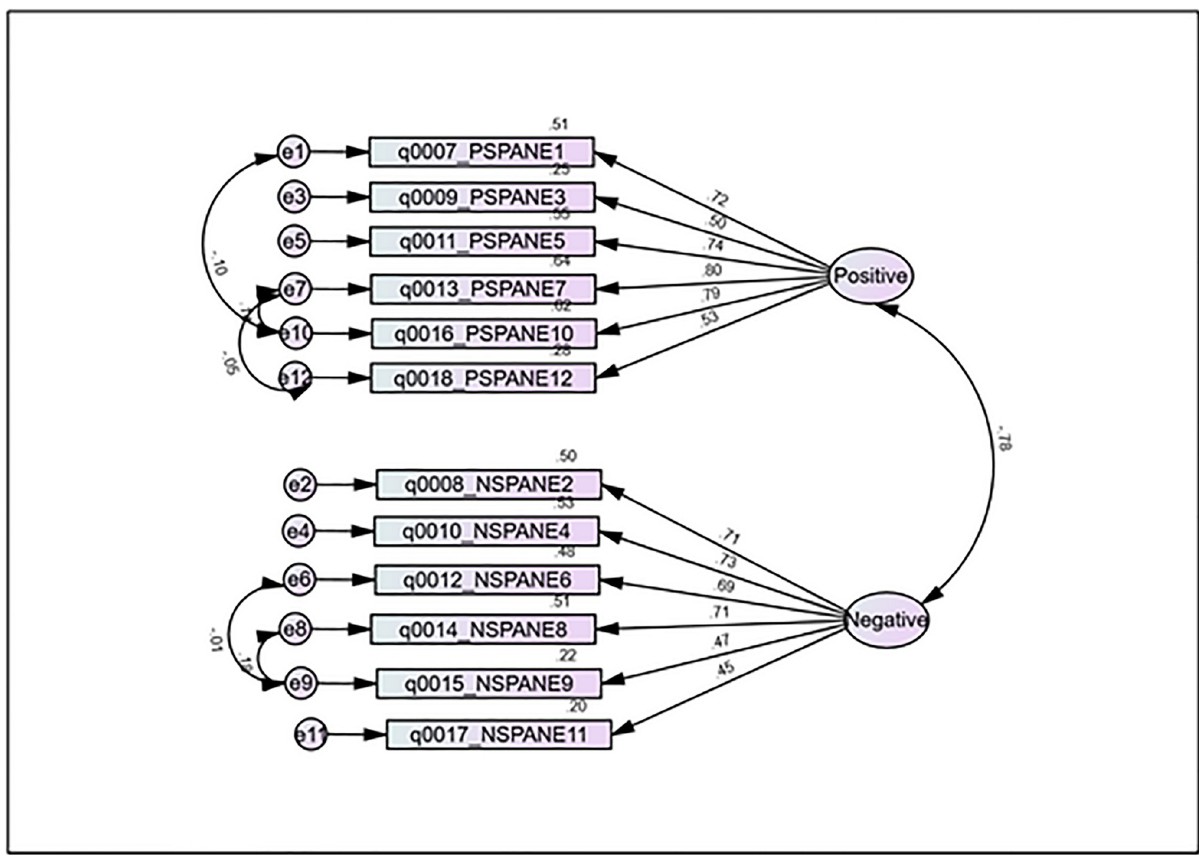
Fig 1. Graphical representation the two-factor model of SPANE as demonstrated by the confirmatory factor analysis. Loadings shown are standardized loading.